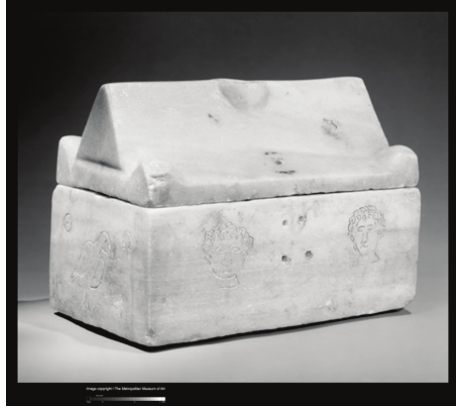
Figure 8: Early Byzantine reliquary sarcopha- gus. © The Metropolitan Museum of Art Im- age source: Art Resource, NY